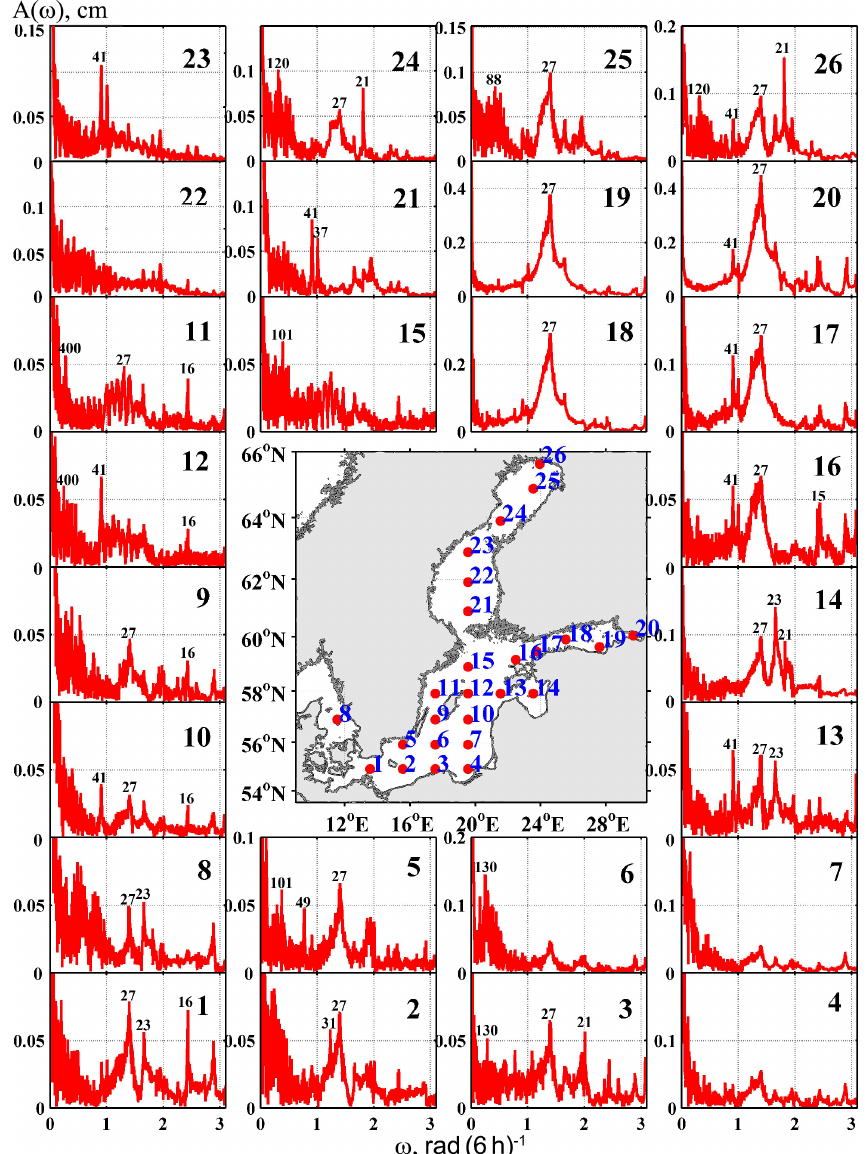
Figure 11. Amplitude spectra A(ω) of free oscillations in baroclinic conditions in different parts of the Baltic Sea. Numbers above the peaks show oscillation periods in hours. Locations of points are shown on the